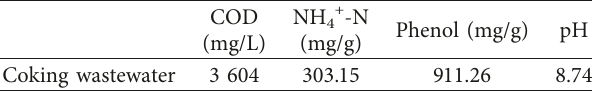
Table 2: Main index of coking